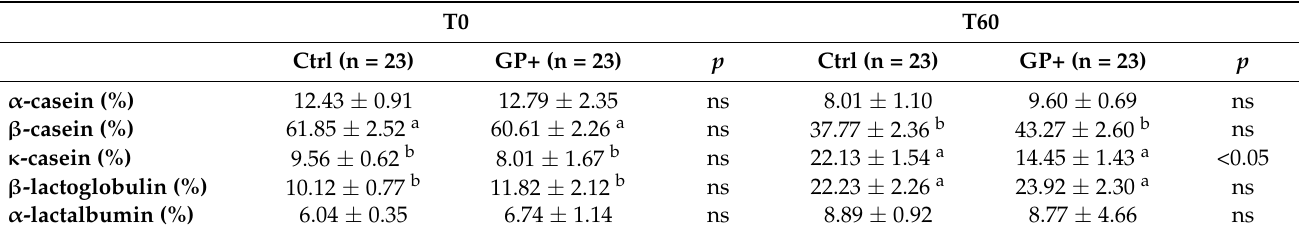
Table 4. Densitometric analysis of SDS-PAGE protein bands at the beginning (T0) and after 60 (T60) days of trial in raw milk samples obtained from ewes fed a standard diet (Ctrl) and grape pomace diet (GP+).